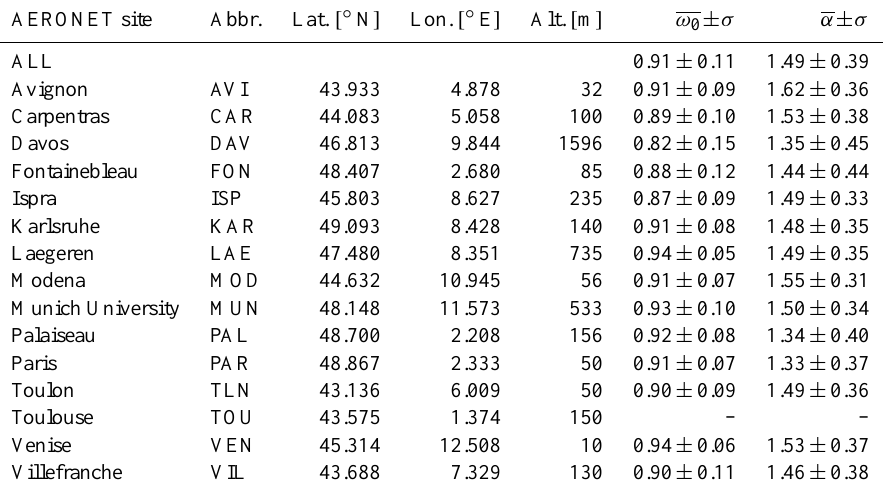
Table 1. AERONET sites in Central Europe (40.5 ◦ N–50 ◦ N, 0 ◦ E–17 ◦ E) included in the validation. Beside the abbreviation used for the analysis later on, the geographical coordinates and the altitude of each site, information about the aerosol model in terms of the average and standard deviation of the single scattering albedo ω 0 and ˚Angstrom wavelength exponent α for the period between August 2005 and December 2007 is included as well (cf. Sect.